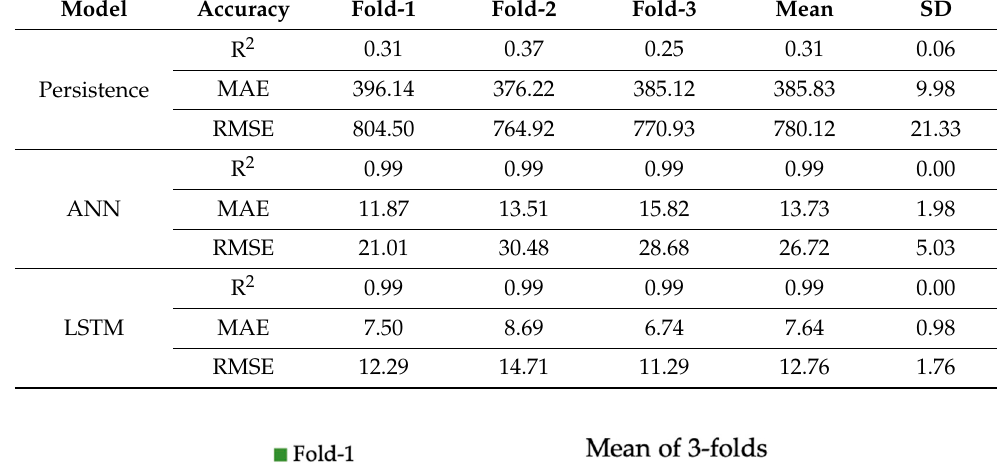
Table 7. The HPCF accuracy for both ANN and LSTM evaluated models in the EAS METER.